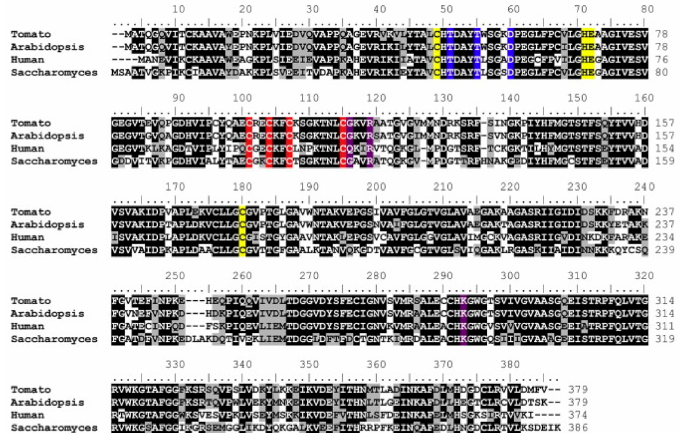
Figure 4. GSNOR amino acid sequence alignment showing conserved residues [6]. There are conserved cysteine residues at cys10, cys271 and cys370; possible S-nitrosation sites.